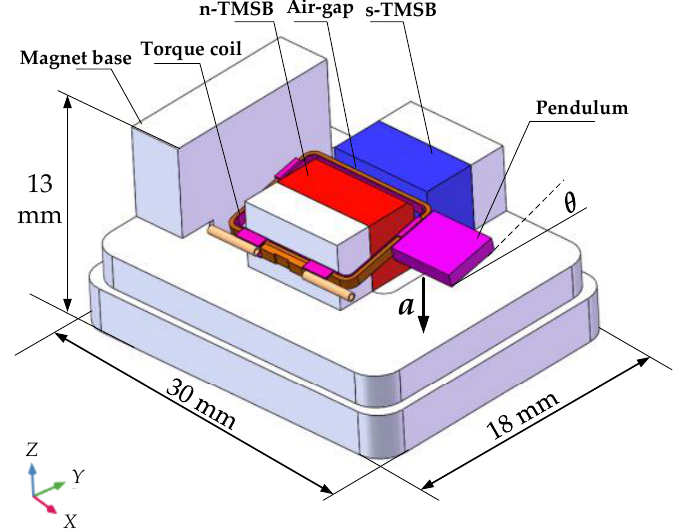
Figure 2. Schematic drawing of pendulum accelerometer. The TMSP is mainly composed of a s-TMSB and a base with a glued n-TMSB (N-pole of the n-TMSB and S-pole of the s-TMSB are set oppositely, and magnetized direction is Y -direction). With COMSOL software (COMSOL Inc. Stockholm, Sweden), the simulation of magnetic field distribution is carried out. Related parameters are shown in Table 1. Table 1. Parameters for simulation. Object